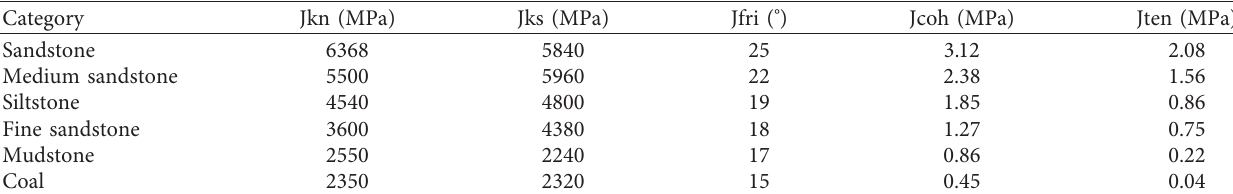
Table 6: The mechanical parameters of